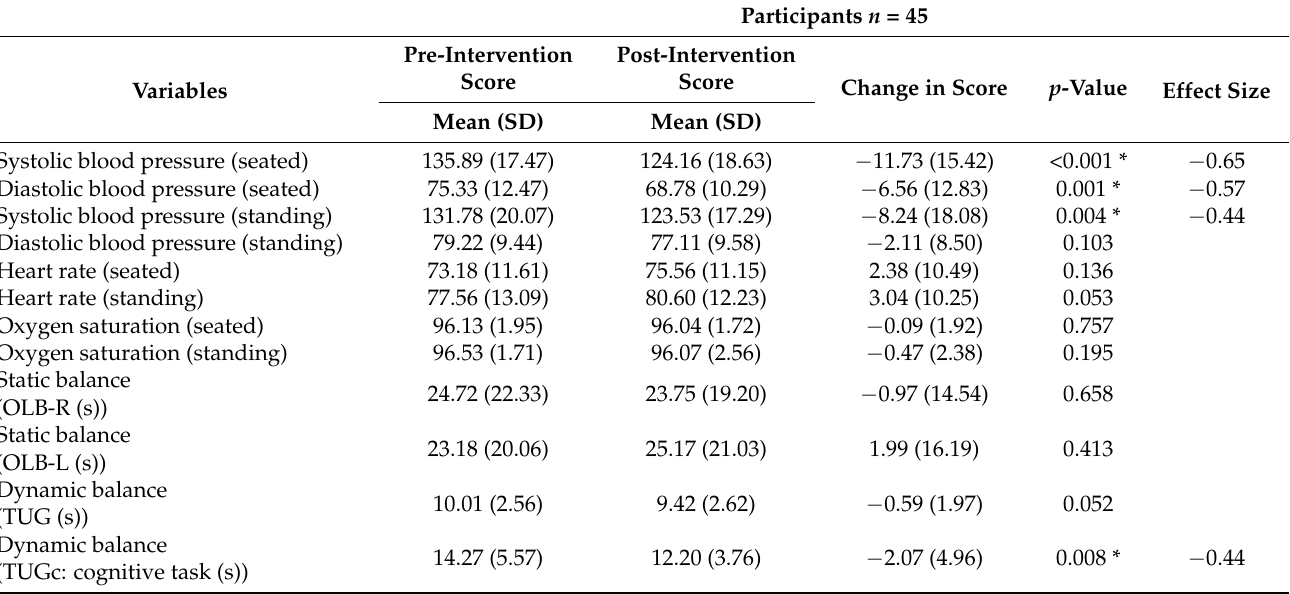
Table 3. Pre–post intervention comparison for clinical variables and anthropometrics among partici- pants of a structured multicomponent physical exercise